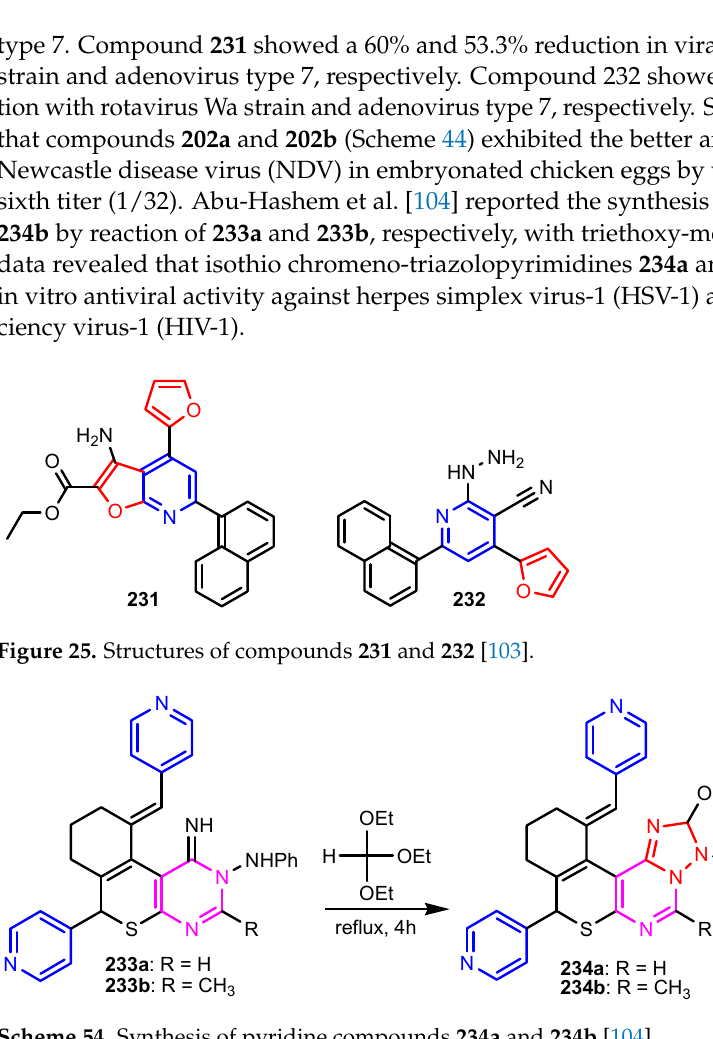
Scheme 54. Synthesis of pyridine compounds 234a and 234b